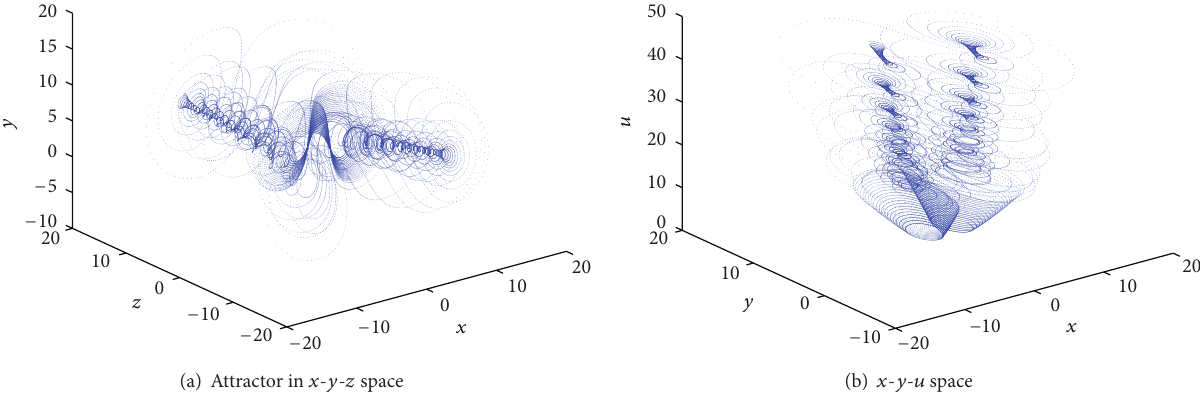
Figure 2: Phase portraits of system (3) with 𝑞 1 = 0.96 , 𝑞 2 = 0.94 , 𝑞 3 = 0.92 , 𝑞 4 = 0.78 , 𝑎 = 3 , 𝑏 = 0.4 , 𝑐 = 0.4 , and 𝑑 = 0.1